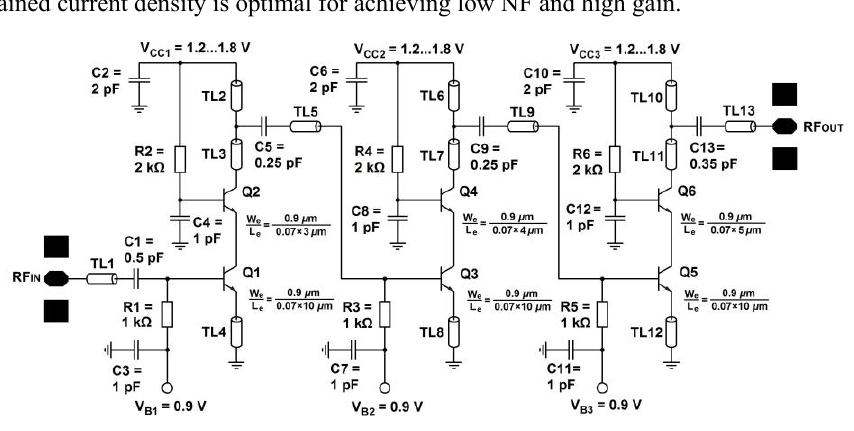
Fig. 1. Schematic of the 3-stage cascode LNA. Table 1. Summary of the size of all TL.